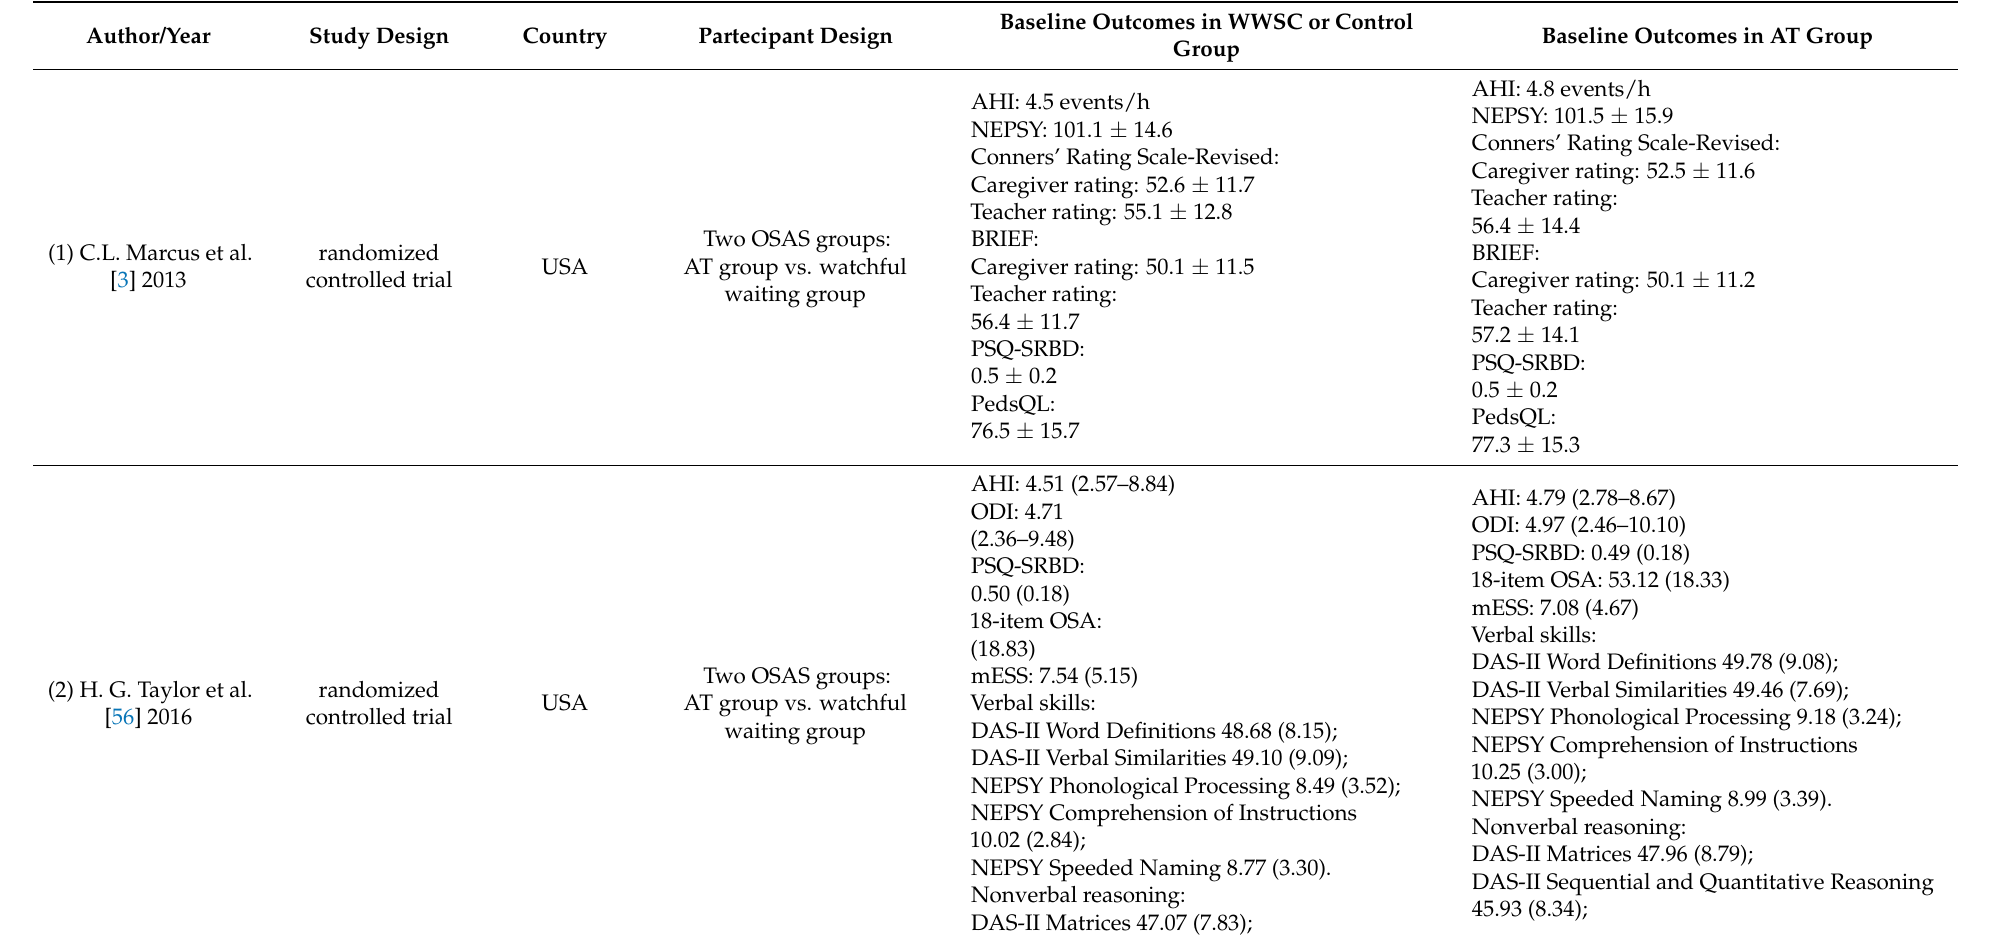
Table 3. Baseline outcomes in WWSC group, control group or AT